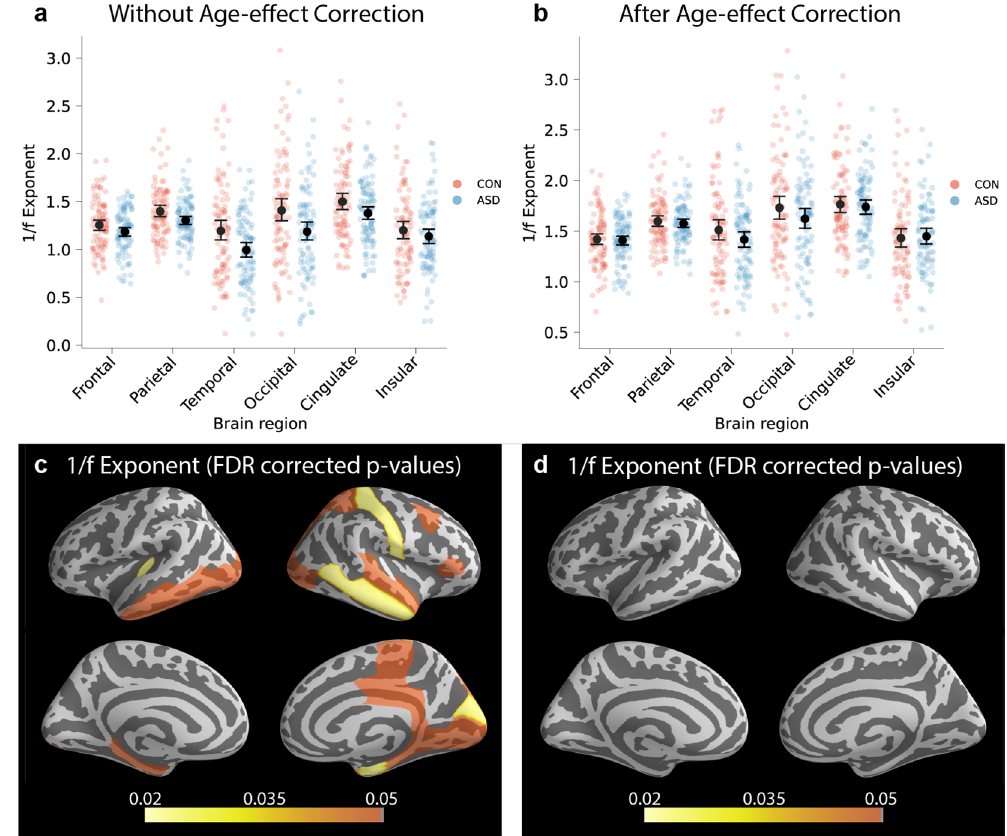
Figure 3. The effect of age on 1/f exponents. ( a , c ) Prior to age-effect correction of 1/f exponents, we observed a significant difference in group-means. ( b , d ) However, this effect was confounded by age, as evident by the lack of significant effects after we corrected for the age-effect. Mean with 95% confidence intervals are